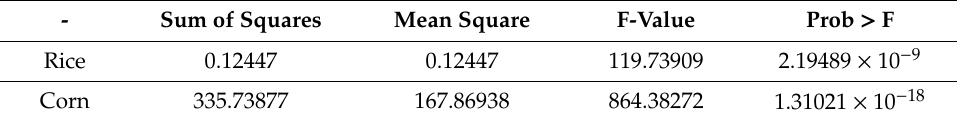
Table 9. Test results of the regression equation significance for an 80% fragmentation